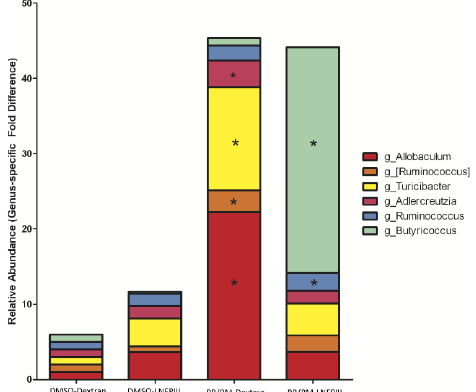
the key to the right of each cladogram.